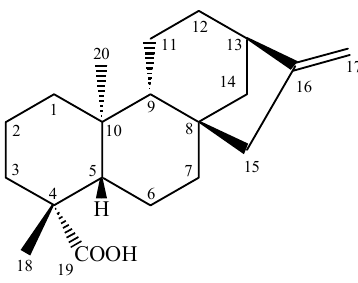
Figure 2 . Chemical structure of ent